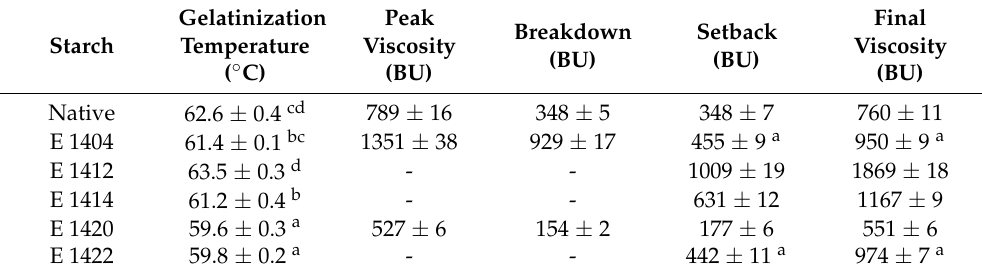
Figure 1. Pasting curves of native and modified potato starches recorded by Brabender viscograph. Table 1. Pasting parameters of modified potato starches recorded by Brabender viscograph.